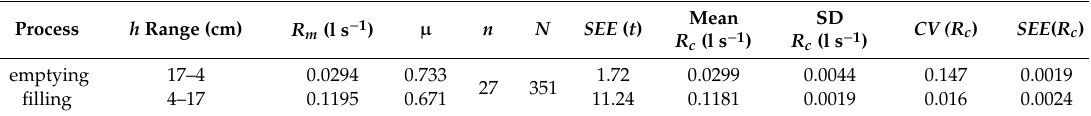
Figure 7. ( a ) Experimental water tank, ( b ) ring where the sharp-crested orifice is inserted, and ( c ) top Figure 7. (a) Experimental water tank, (b) ring where the sharp-crested orifice is inserted, and (c) top and bottom view of the sharp-crested orifice. and bottom view of the sharp-crested orifice. Table 7. For the considered emptying and filling processes, h range, runo ff discharge, R , and runo ff coe ffi cient, µ , and corresponding main